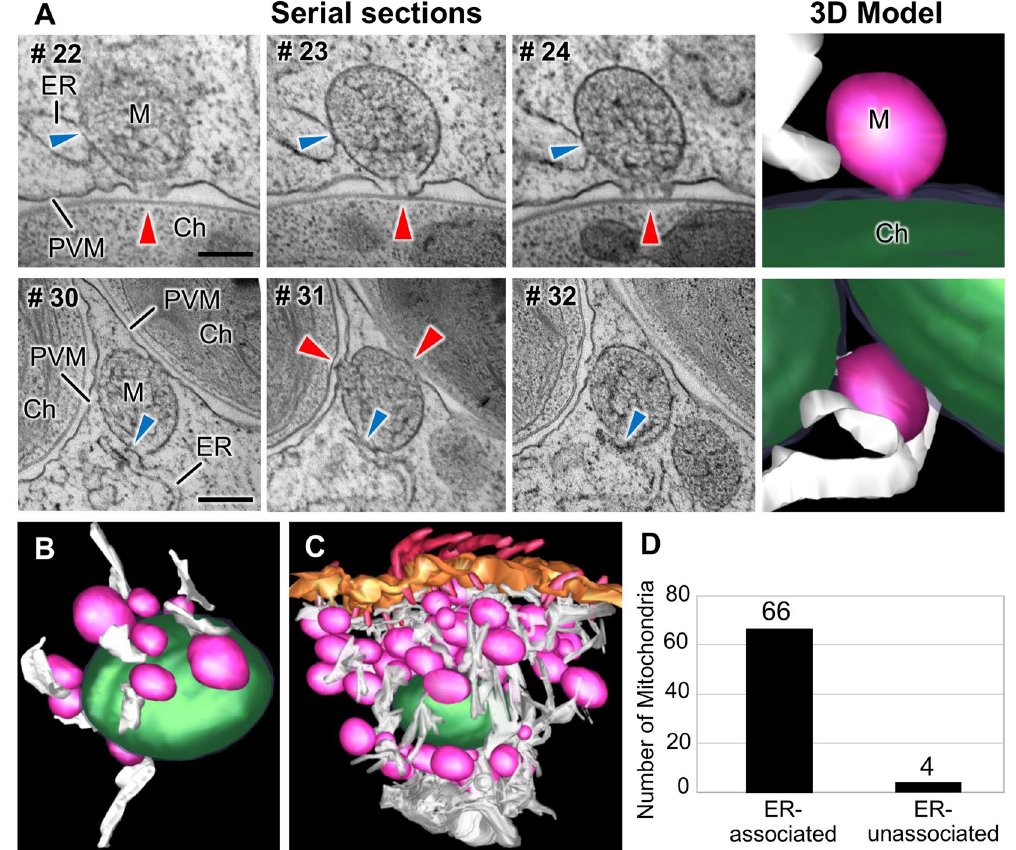
Figure 5. Connections between mitochondria and the ER in P . bursaria . ( A ) TEM images of serial sections of P . bursaria showing the associations between mitochondria, ER, and symbiotic zoochlorella through the PVM. The red and blue arrowheads indicate the sites at which mitochondria are connected to the symbiotic zoochlorella and ER, respectively. The panels on the right show the 3-D segmentation models of the mitochondrial connections; in these images, mitochondria, zoochlorellae, and ER are colored by pink, green, and white, respectively. Scale bars: 500 nm. ( B ) A 3-D segmentation model showing that all of the mitochondria associated with the symbiotic zoochlorella are connected to the ER. ( C ) A full volume 3-D model showing the network of mitochondria connected with ER at the subcortical area of P . bursaria . ( D ) The numbers of ER- associated and -unassociated mitochondria in the full volume 3-D model. Ch, zoochlorella; ER, endoplasmic reticulum; M, mitochondrion; PVM, perialgal vacuole